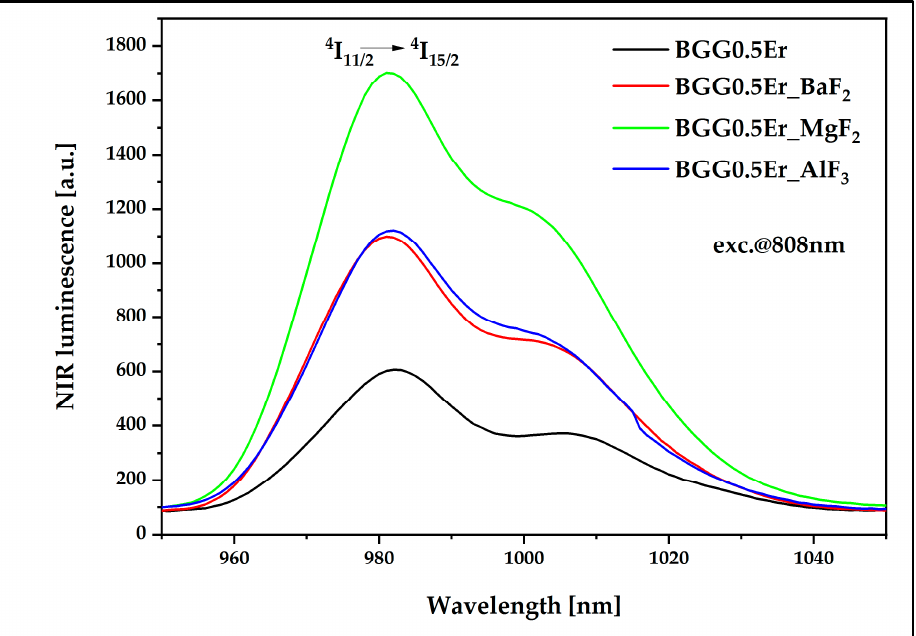
Figure 23 . Near-infrared luminescence spectra of Er 3+ -doped BGG glass modified by different fluoride compounds under 808 nm laser excitation.